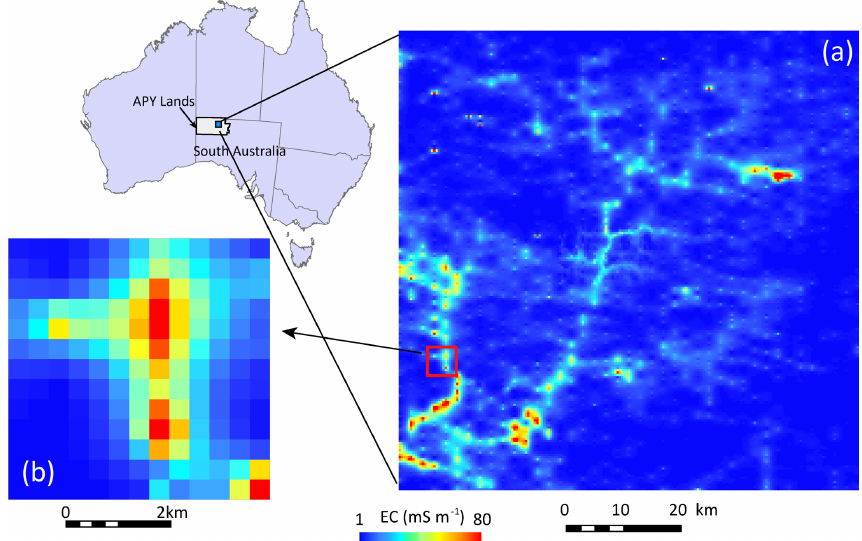
Figure 1. (a) Electrical conductivity at 100m depth ranging from 1 to 80mSm − 1 , as interpreted from airborne electromagnetic surveys in the Anangu Pitjantjatjara Yankunytjatjara (APY) lands, Australia; (b) inset shows details of EC map at a spatial resolution of 400m × 400m (Soerensen et al.,